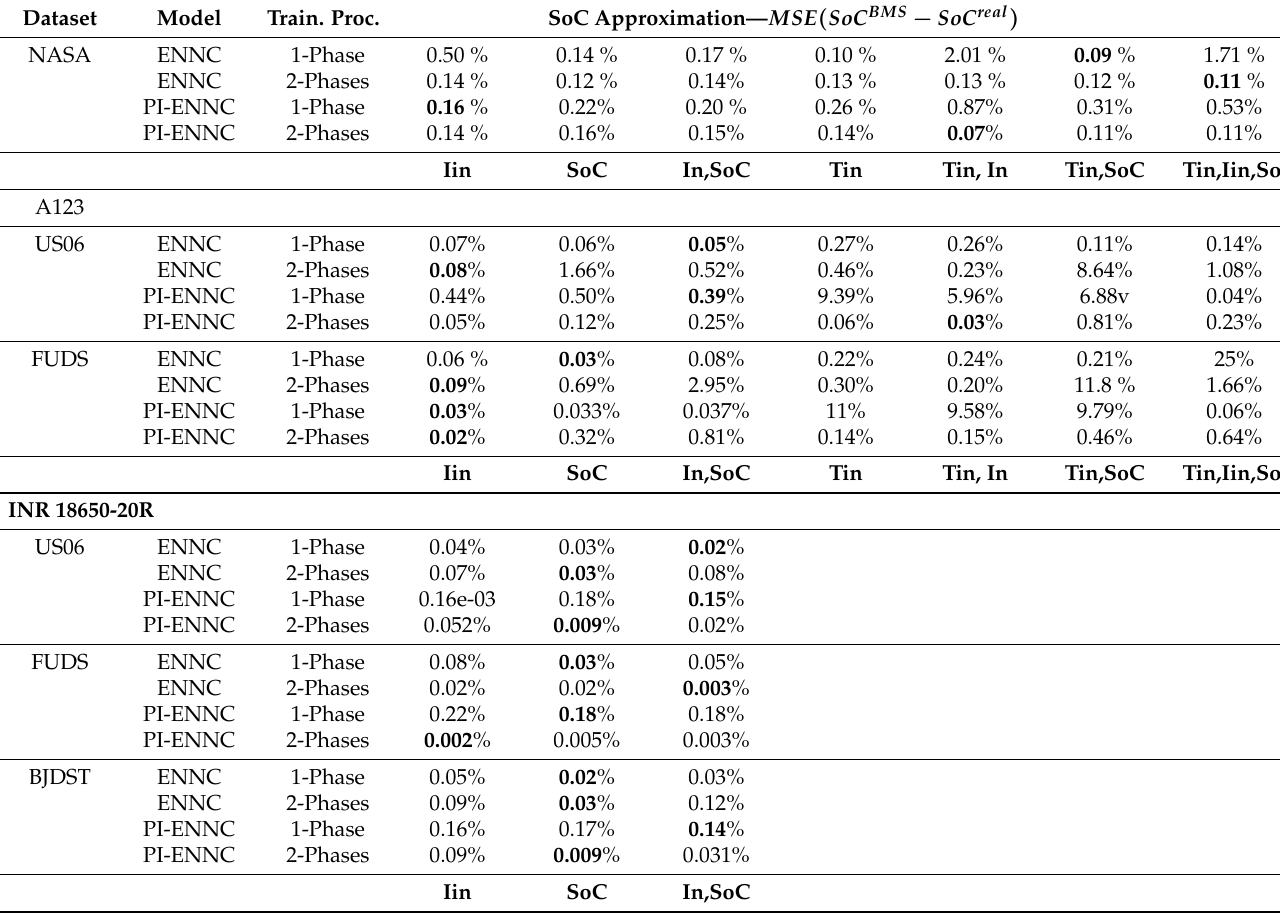
Figure A6. SoC and V out time series referring to the INR 18650-20R-BJDST dataset considering the best PI-ENNC BMS model on the test set. Table A1. Test result on SoC MSE (in percent) sorted per dataset, BMS model, training procedure and input tuple definition. Dataset Model Train.